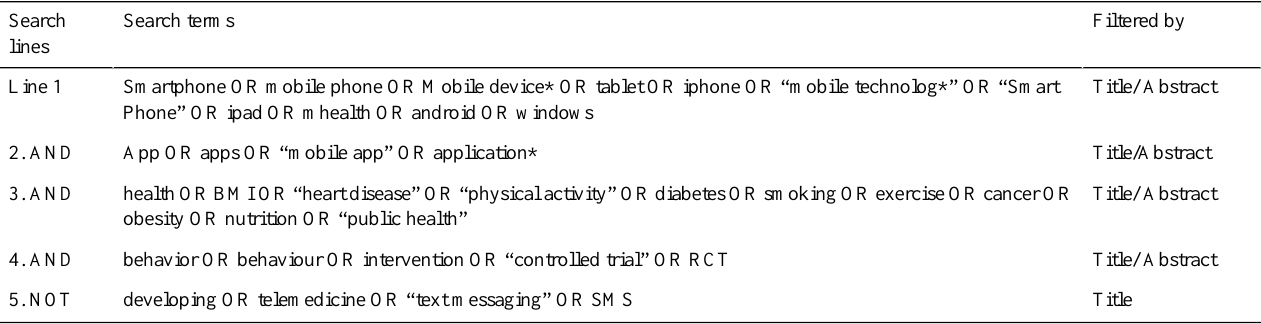
Table 1. Search terms for systematic